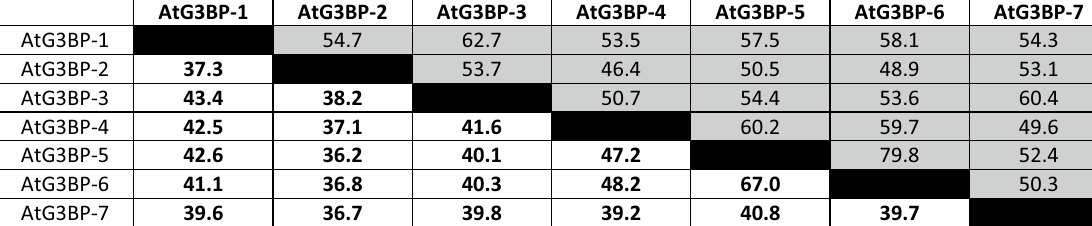
Table 1. Sequence similarity of the different AtG3BPs in %. The protein sequence similarity (shaded in grey) and the nucleotide sequence identity (white boxes) of the coding sequences were calculated based on the ClustalW alignment with the BLOSUM62 matrix and a threshold of 0.